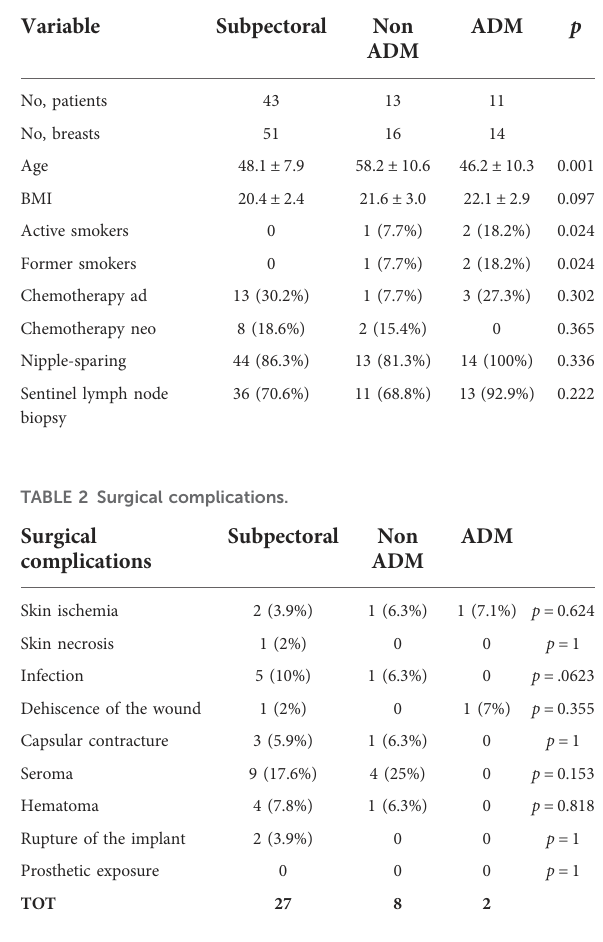
TABLE 1 Clinical characteristics. TABLE 3 Aesthetic complications.